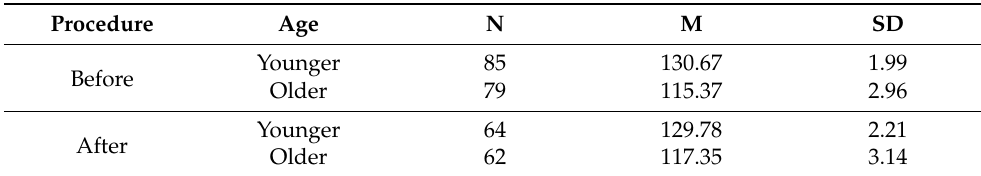
Table 5. Descriptive statistics of the patient’s body assessment, divided by age, before and after the procedure.